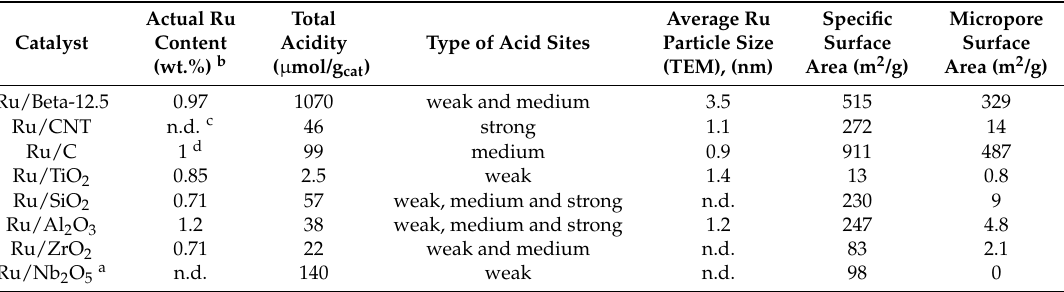
Table 3. Overview of catalyst characterization